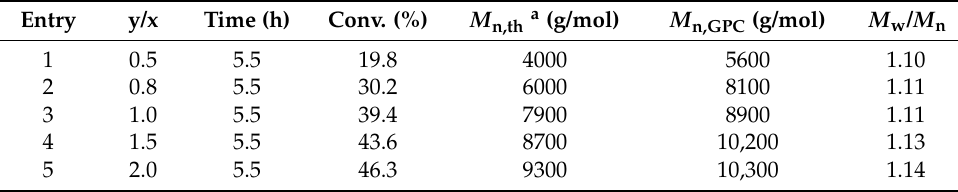
Table 3. Effect of molar ratio of [CuBr 2 ] 0 :[AIBN] 0 on polymerization.